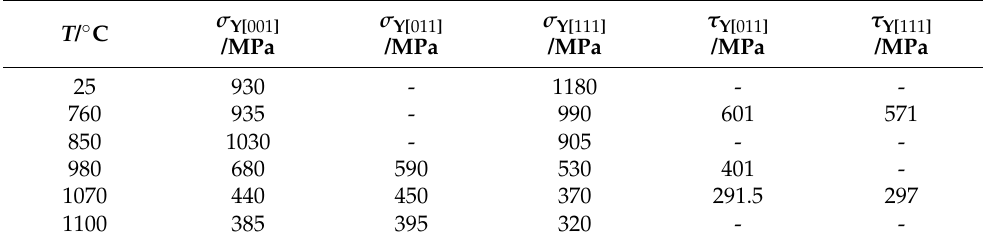
Table 2. DD6 material yield strength data adapted from reference [24].